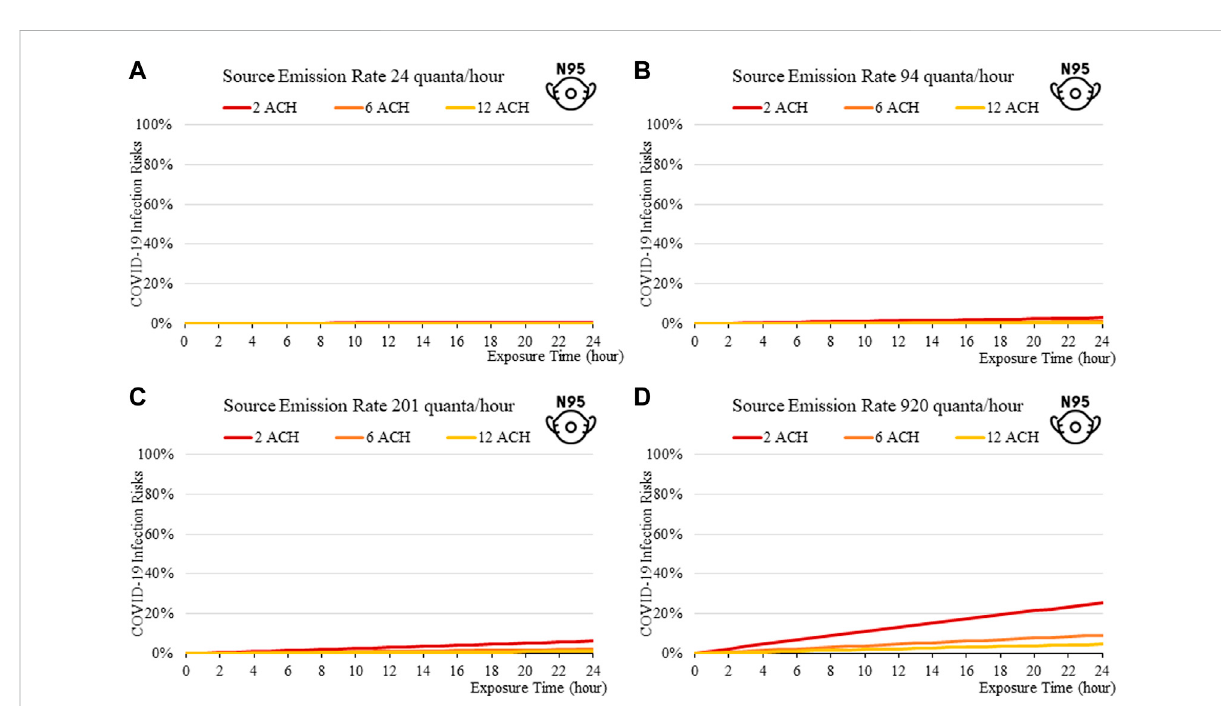
Disease infection risks for the Omicron variant, assuming the receiver and index patient are both wearing an N95 respirator face mask (99% Inward and Outward Filtration Ef fi ciencies): Assuming the exhale quanta emission rate of 24 (A) , 94 (B) , 201 (C) , and 920 (D) quanta/hour for the